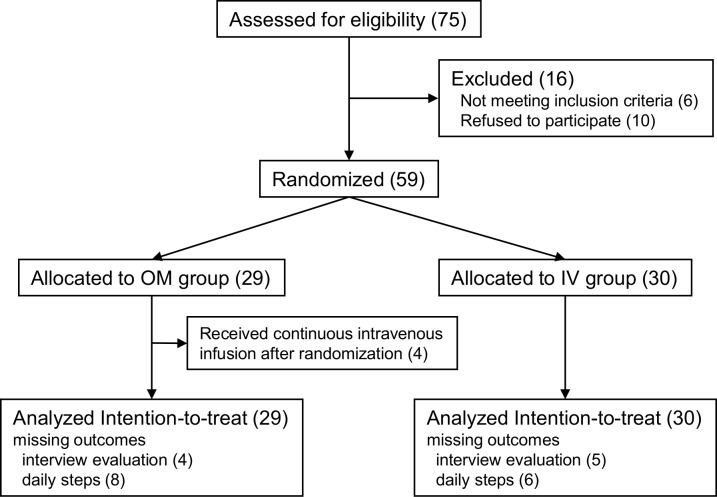
CONSORT (Consolidated Standards of Reporting Trials) flow chart of the study participants.